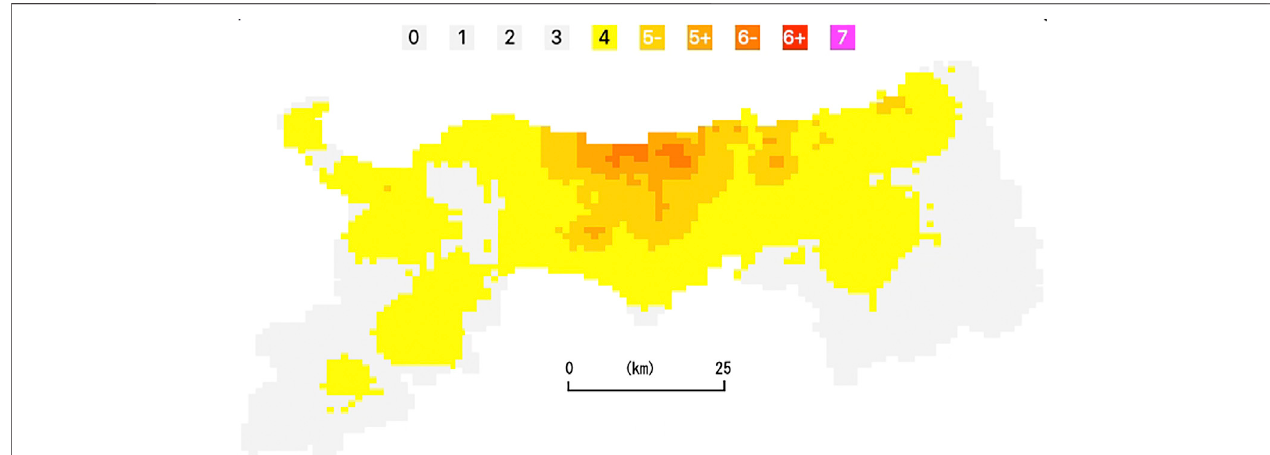
FIGURE 5 | Same as Figure 2 but after introducing attenuation and secondary source points.